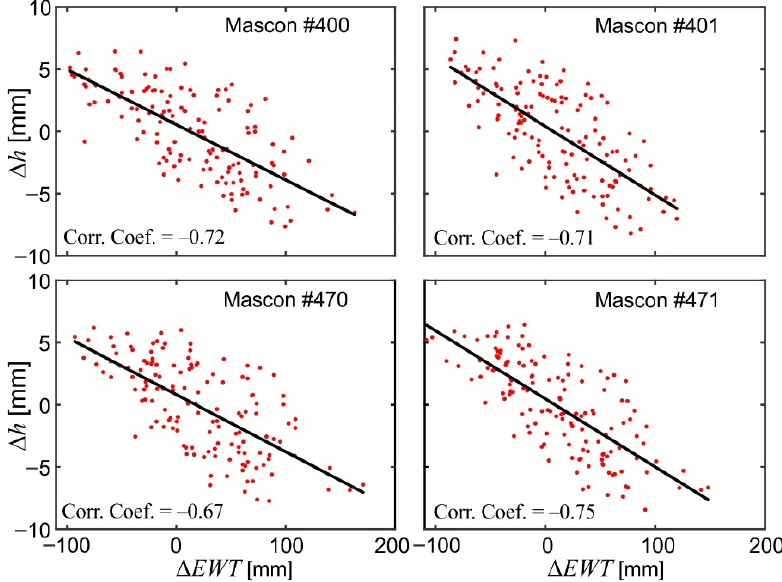
Figure 8. Correlations between temporal variations of equivalent water thickness ( Δ EWT ) and vertical deformations of the Earth’s surface ( Δ h ) over Poland.